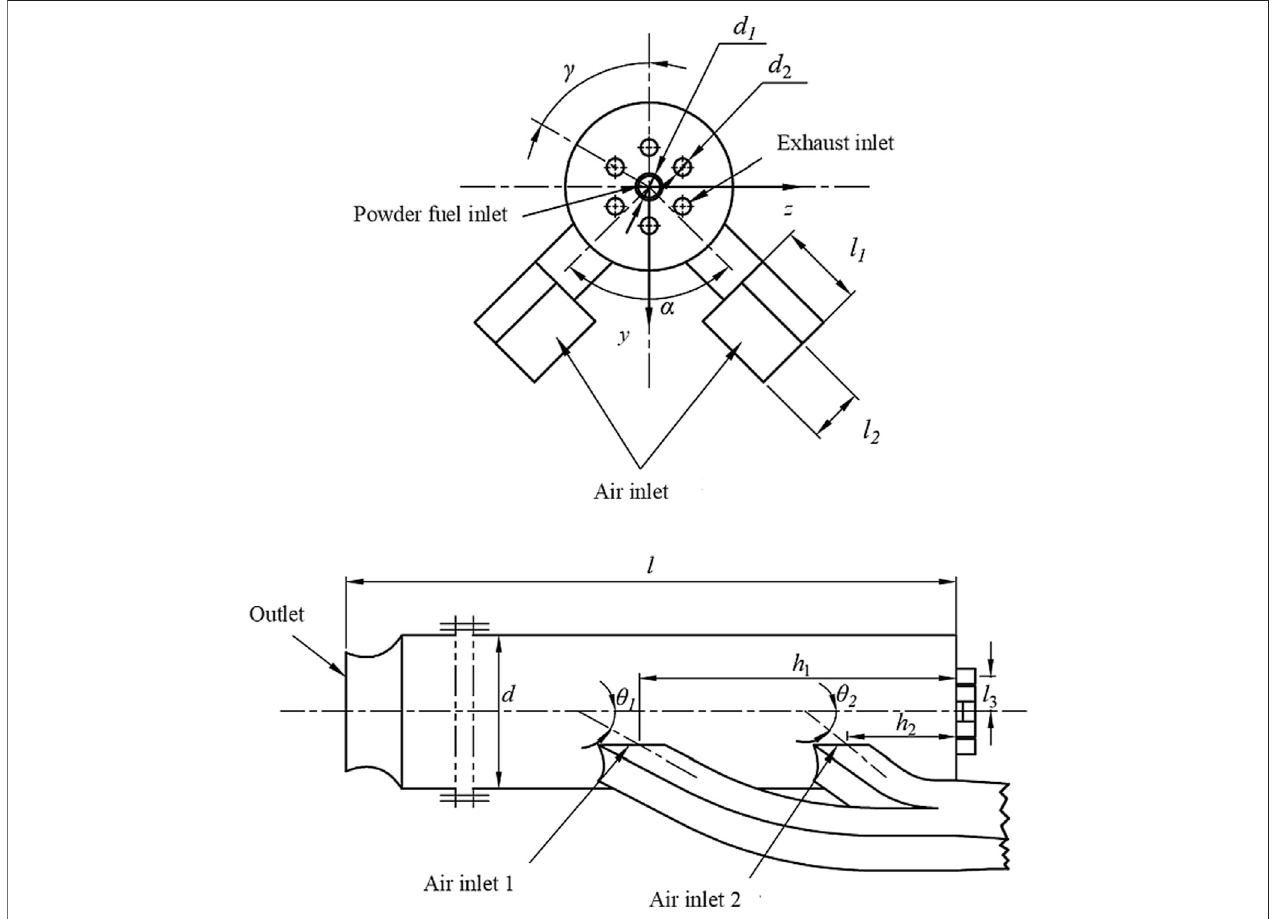
FIGURE 2 | Related geometric parameters of the combustion